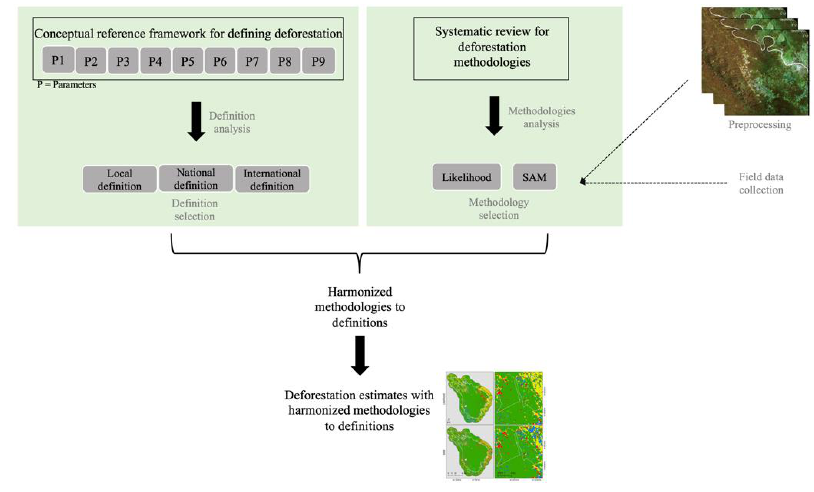
Figure 2. Flowchart describing the methodology.